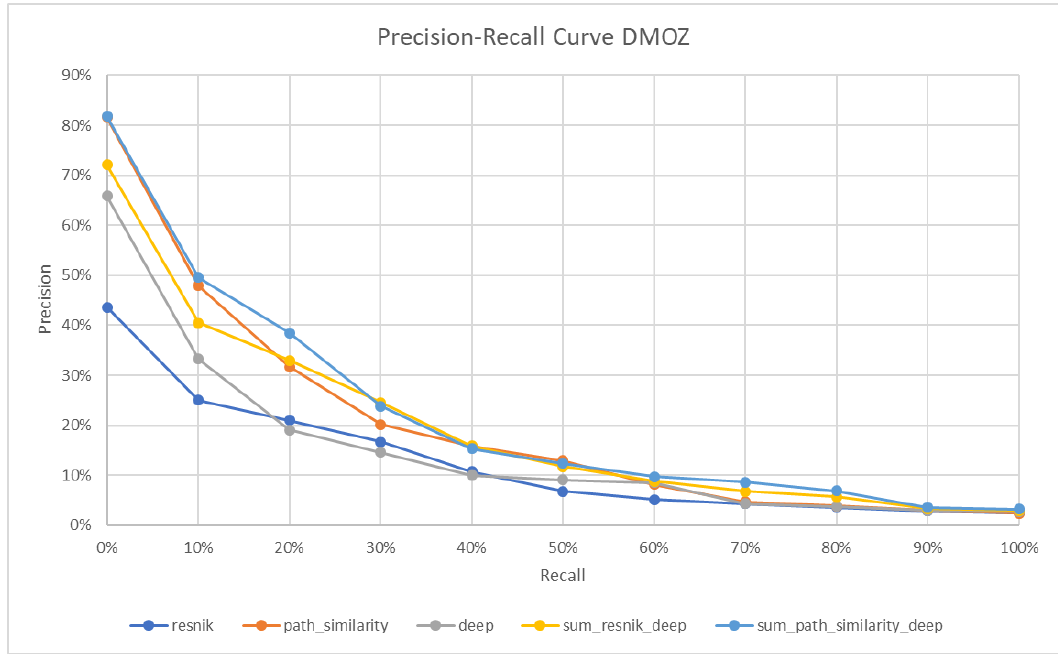
Figure 15. Precision-Recall Curve